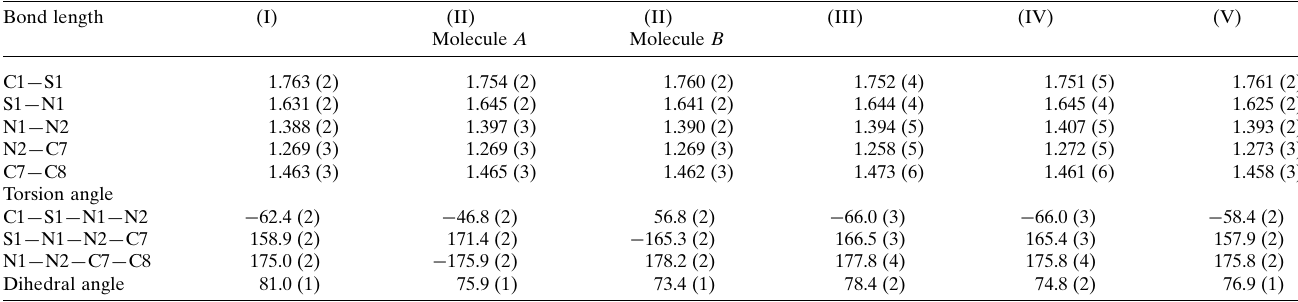
Table 1 Comparison of selected geometrical parameters (A˚ , (cid:3) ) of compounds (I)–(V). The dihedral angle is that between the aromatic rings. The equivalent bond lengths and torsion angles are given for (II B ). Bond